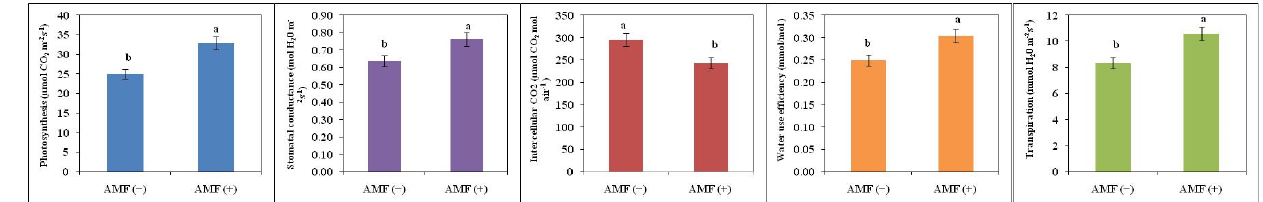
Figure 3. Rate of photosynthesis, stomatal conductance, intercellular CO 2 , water use efficiency, and rate of transpiration of non-inoculated AMF ( − ) and inoculated plants AMF (+) of soybean. The vertical bar indicates ± SE for the mean. The means for each main treatment followed by the different letters are significantly different ( p ≤ 0.05).